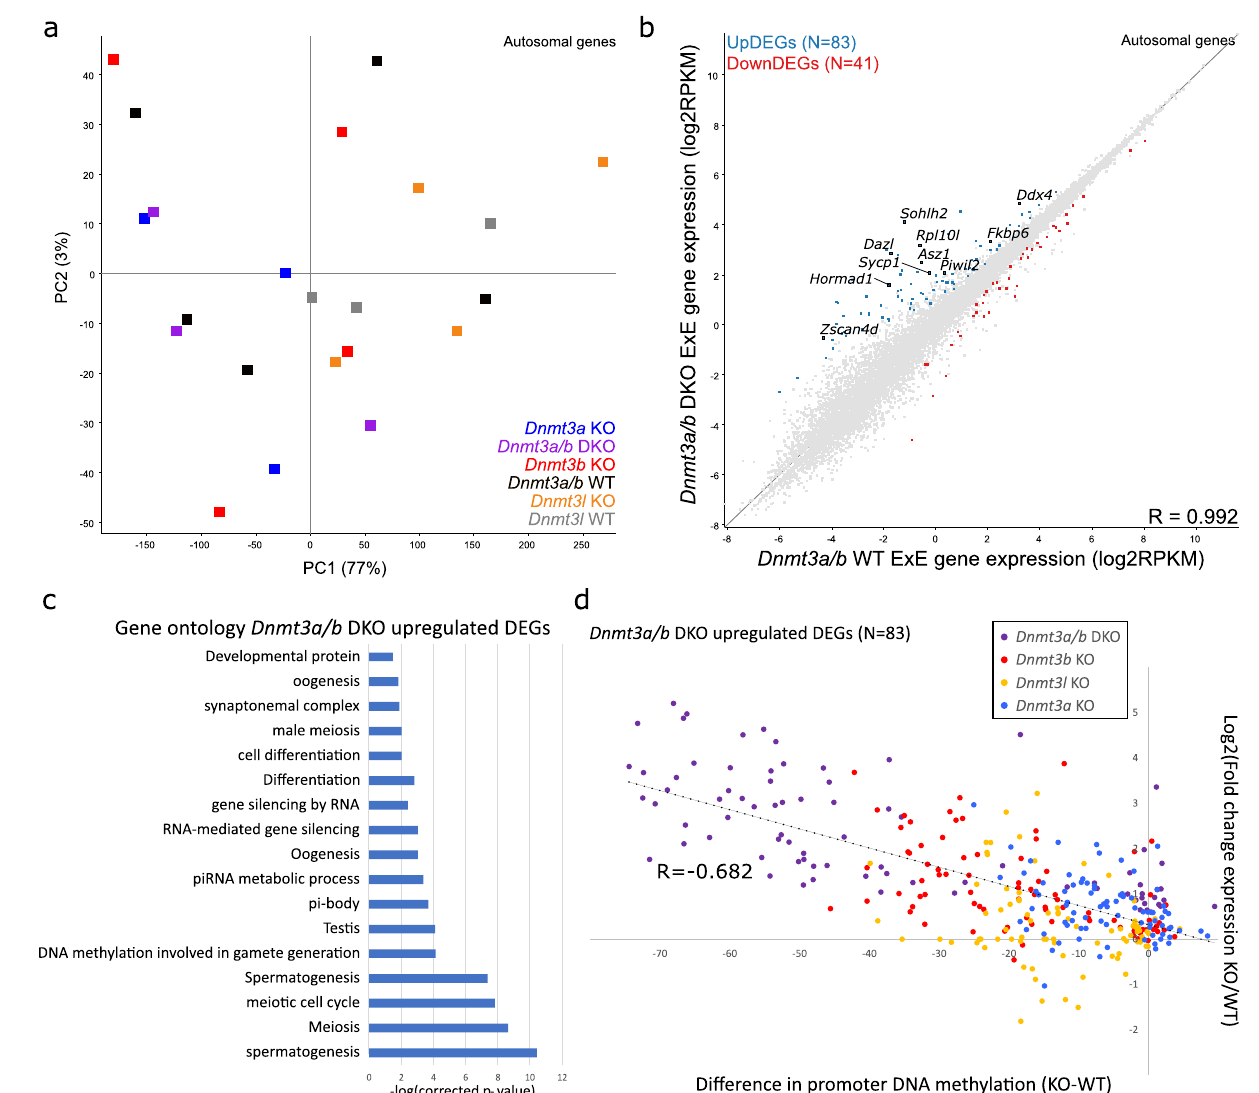
Fig. 3 | Loss of DNA methylation in ExE results in de-repression of germline genes. a The principle component plot shows the distribution of gene expression replicates for Dnmt3a , Dnmt3b , Dnmt3l , Dnmt3a/b DKO and wildtype (WT) extra- embryonicectoderm(ExE).Gene expressionwas quantitated forautosomalgenes, using log2(RPKM). b The scatterplot compares gene expression between Dnmt3a/ 3b DKO and WT littermate control ExE for autosomal genes. Up- and down- regulated differentially expressed genes (DEGs) are highlighted. c The bar plot